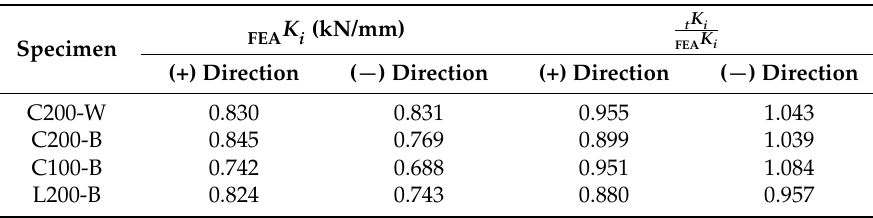
Table 7. Initial stiffness of the FE model (FEA).